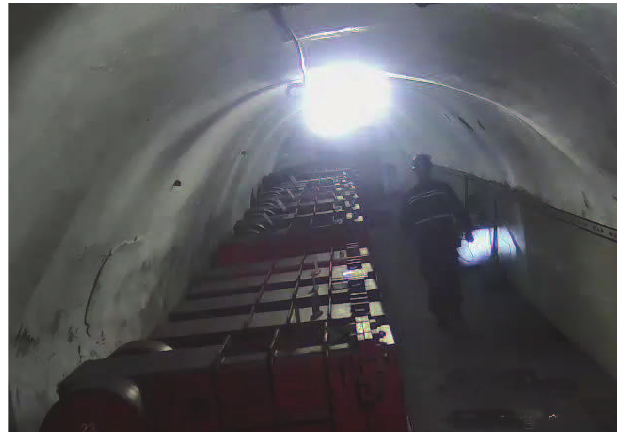
Figure 12. Underground environment.